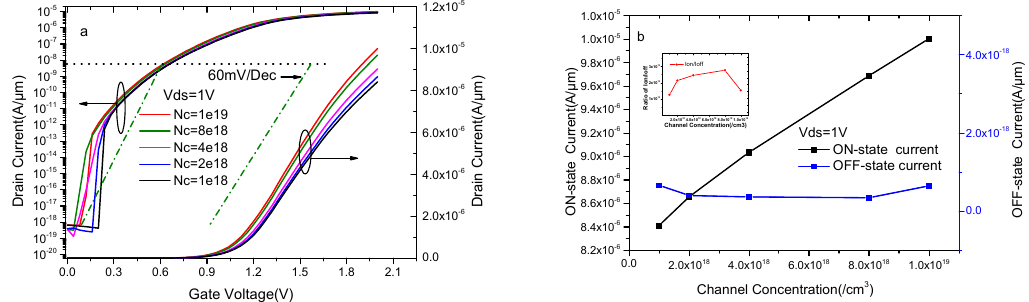
Figure 6. ( a ) Simulated log scale and linear scale transfer characteristics of DMMG-HJLTFET with different channel doping concentration; ( b ) ON-state current, OFF-state current and Ion/Ioff at different channel doping concentration.